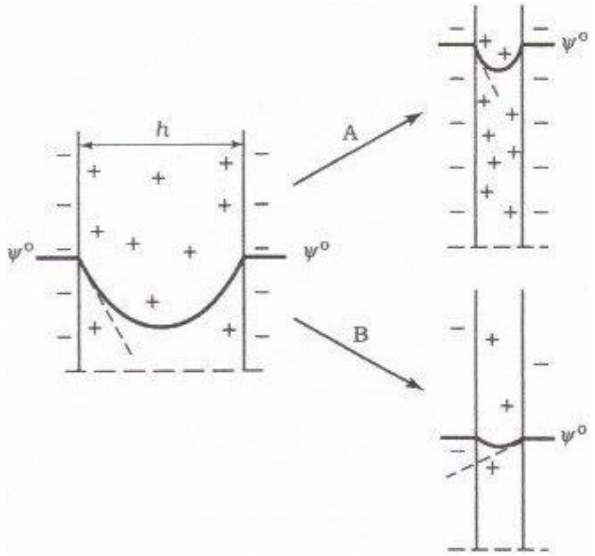
Figure 3. Sketch of the difference between interaction between two diffuse double layers at constant charge (A) and at constant potential (B). In case A, ψ o increases; the nature of the interaction is electric, whereas in case B, σ o decreases and the interaction is of a chemical nature. Dashed lines: the slopes, proportional to the charges because of eq. (1). Reprinted from J. Lyklema, Fundamen- tals of Interface and Colloid Science . Chapter 3: Pair